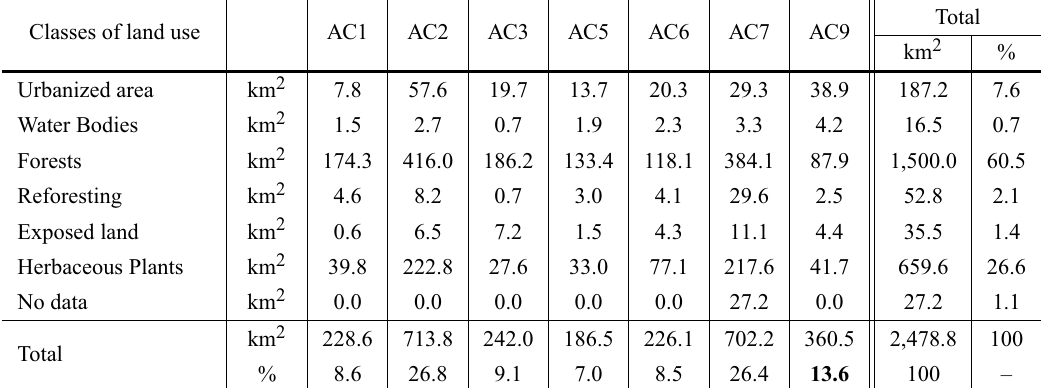
Areas and classes of land use in each area of contribution (AC) in the terminal region of the Itajaí River basin. Classes of land